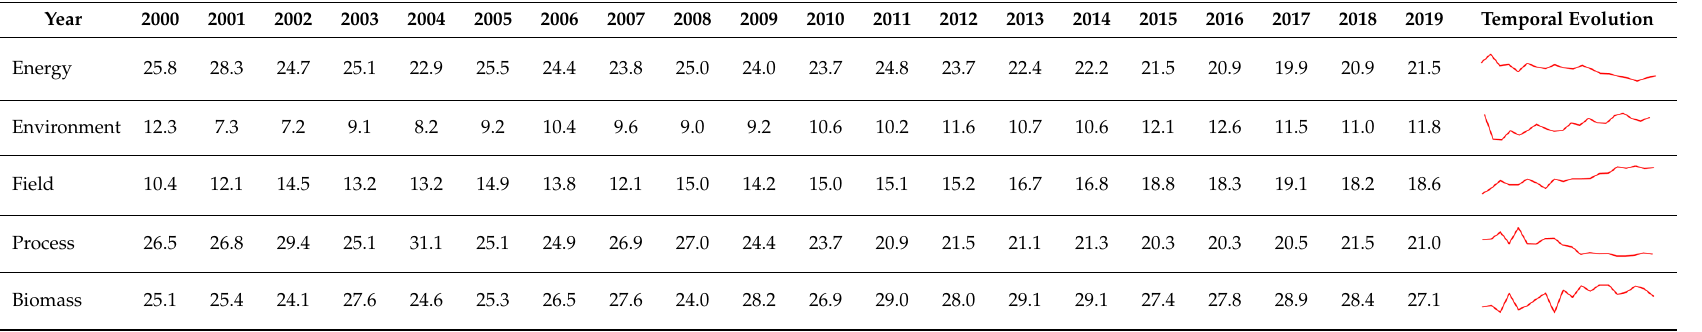
Table 6. Percentage of occurrences in the clusters aggregated by groups of five years.